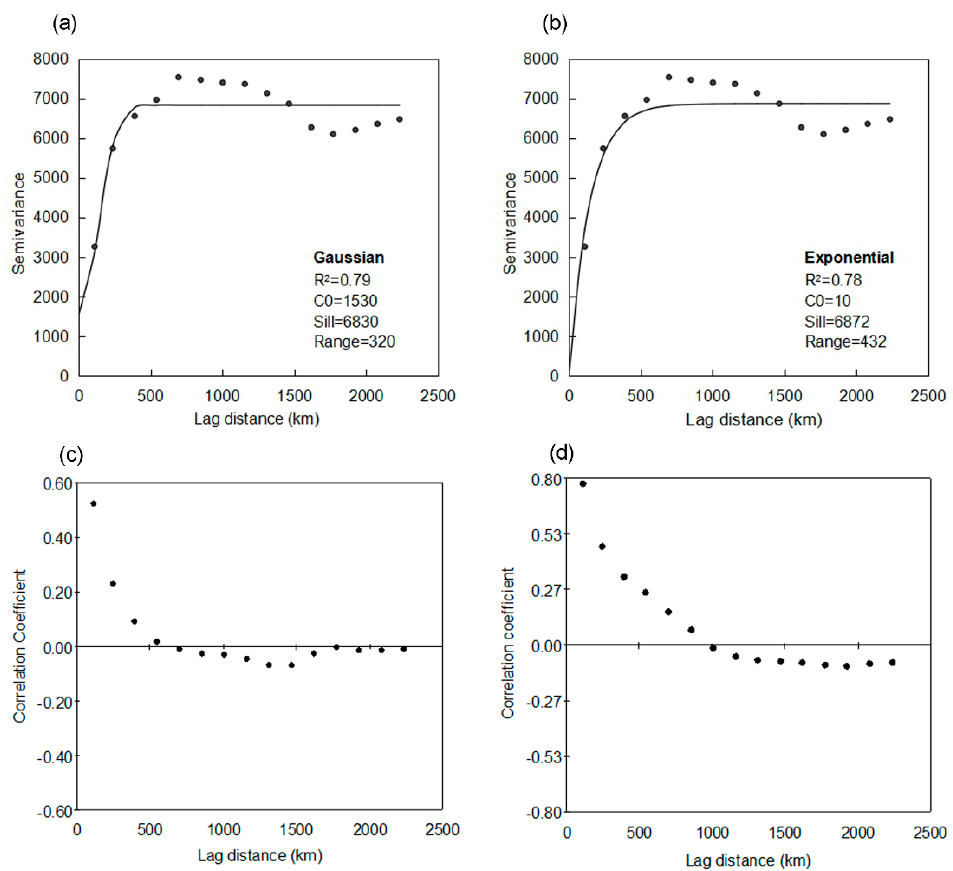
Figure 2. Semi-variogram of block-kriging (BK) gauges rainfall data for ( a ) 3 June 2012 and ( b ) 9 November 2012; cross-correlogram between the BK gauges and TRMM data for ( c ) 3 June 2012 and ( d ) 9 November 2012.